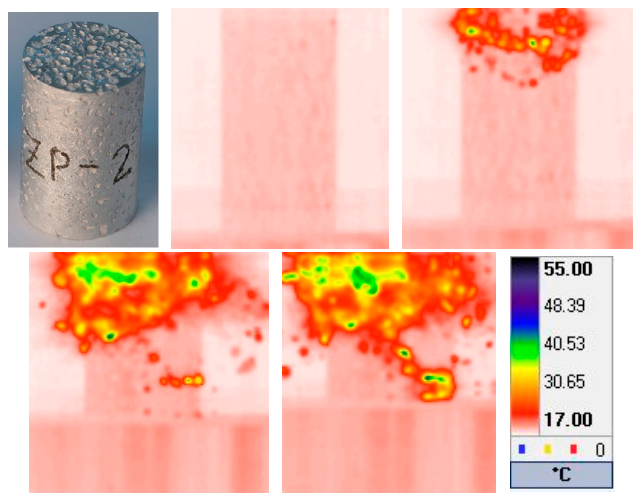
Figure 8. Photo and Infrared (IR) image of aluminum syntactic specimen compressed at the rate of 284 mm/s.